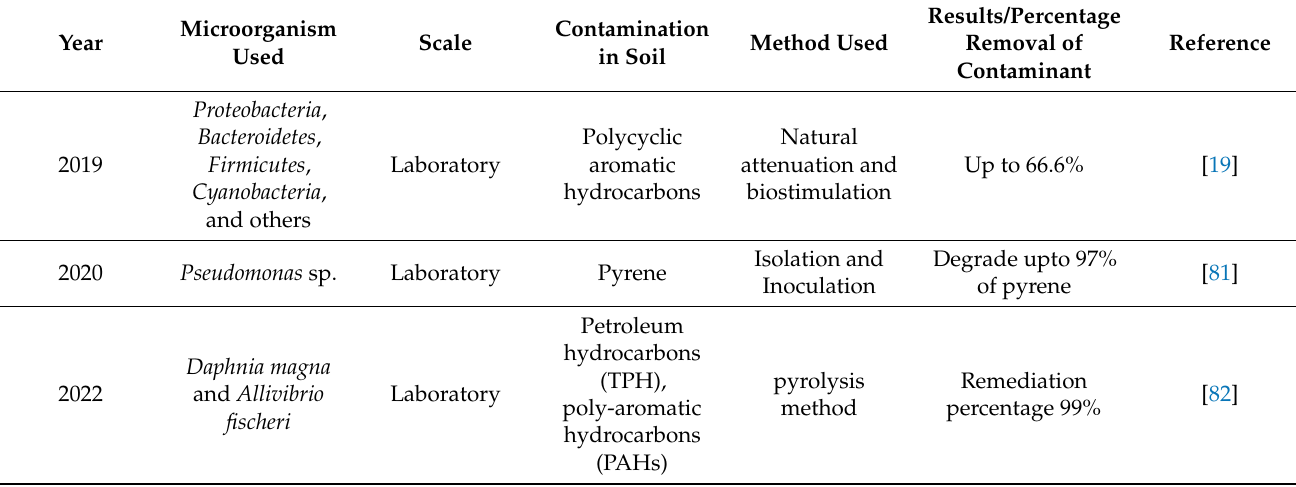
Table 4. The removal rate of Hydrocarbons.